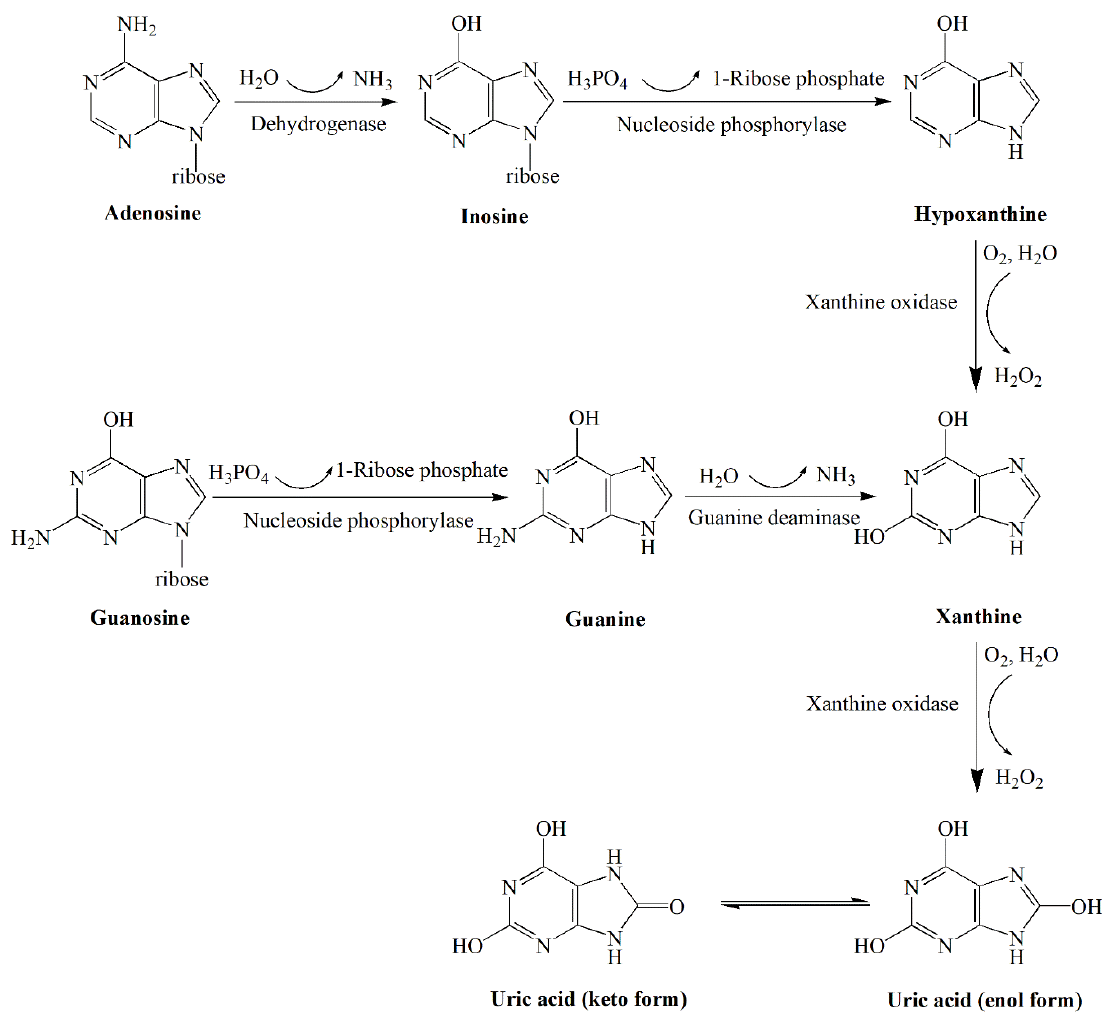
Figure 1. Exogenous purines metabolic pathways.